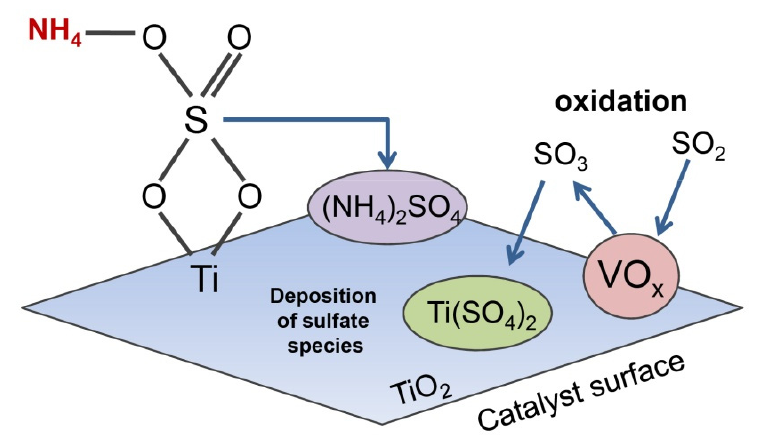
Figure 1. Mechanism of V 2 O 5 -TiO 2 deactivation by SO 2 (based on References [53,59]).